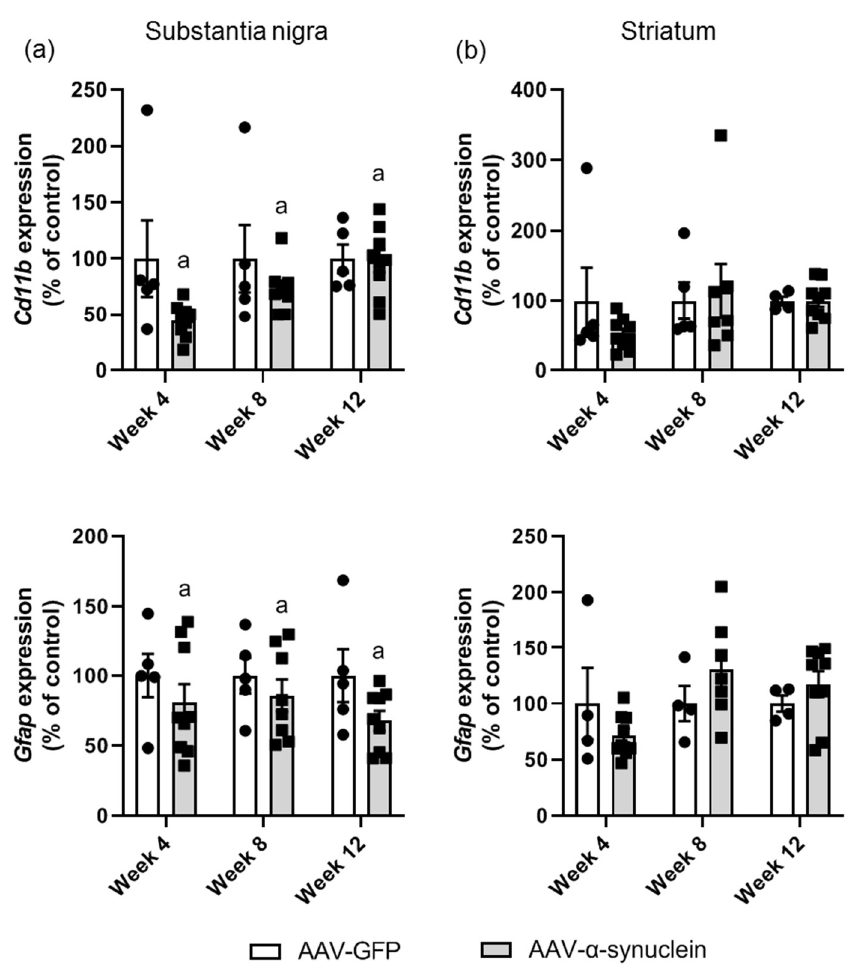
Figure 4. qRT-PCR analyses of astrocytic and microglial markers in the nigrostriatal pathway. In ( a ) the substantia nigra, AAV-α-synuclein administration led to an overall reduction in the expression of the microglial marker Cd11b and the astrocytic marker Gfap . ( b ) There were no differences between groups in the striatum. Data are represented as mean ± SEM with 4–9 animals per group by two-way ANOVA with post hoc Tukey. ‘a’ indicates an overall group effect.